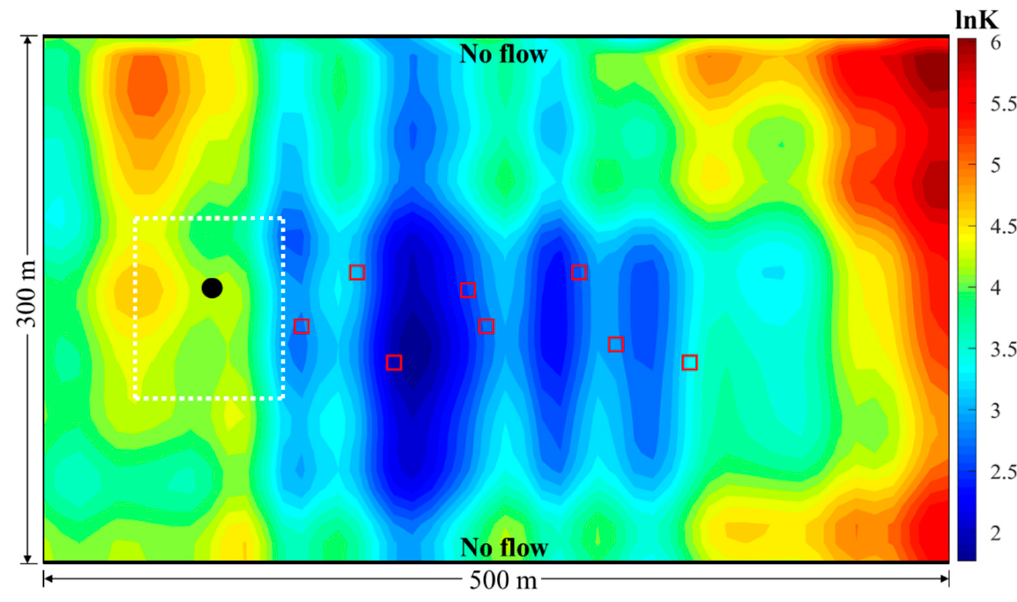
Figure 11. The conceptual model of the two-dimensional confined aquifer considered in Case 3. The background of the model depicts the spatial distribution of the log-conductivity field. The black dot denotes the contaminant source and the red squares denote the observation wells. The white dashed rectangle denotes the potential area of the contaminant source.